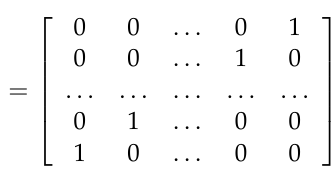
Figure 3. P-Net, R-Net, and O-Net in MTCNN.